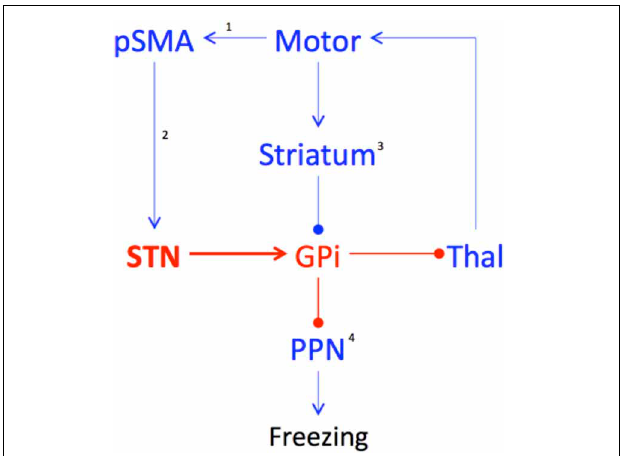
FIGURE 1 | Freezing is due to decreased input and output of the basal ganglia. In periods of high response conflict, the subthalamic nucleus (STN) increases its firing rate, which subsequently drives increased activity within the internal segment of the globus pallidus (GPi), leading to decreased activity within the thalamus (Thal) and the pedunculopontine nucleus (PPN). While the triggering event in this model is currently unknown, it may be due to: 1 —inherent impairment within the pre-supplementary motor area (pSMA), leading to an inefficient communication with the STN; 2 —impairments in the temporal dynamics between the pSMA and STN, possibly due to impaired white matter connectivity; 3 —cellular deficits within the striatum that place the nucleus at an increased risk of becoming hyperpolarized; or 4 —pathology within the PPN, priming the nucleus for hyperpolarization by minimal inhibitory input. Freezing may be due to any combination of these factors. Key: red—increased activity; blue—decreased activity; arrow—excitatory connection; circle—inhibitory